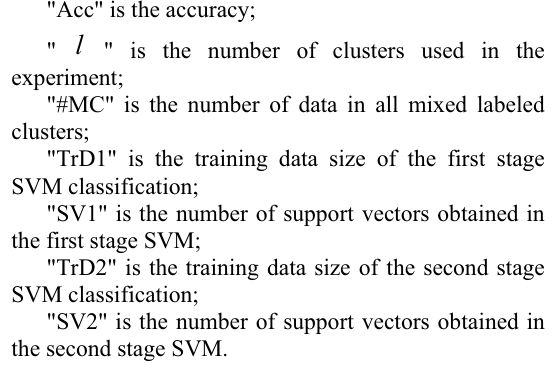
Table 1. Two-stage SVM classification results on